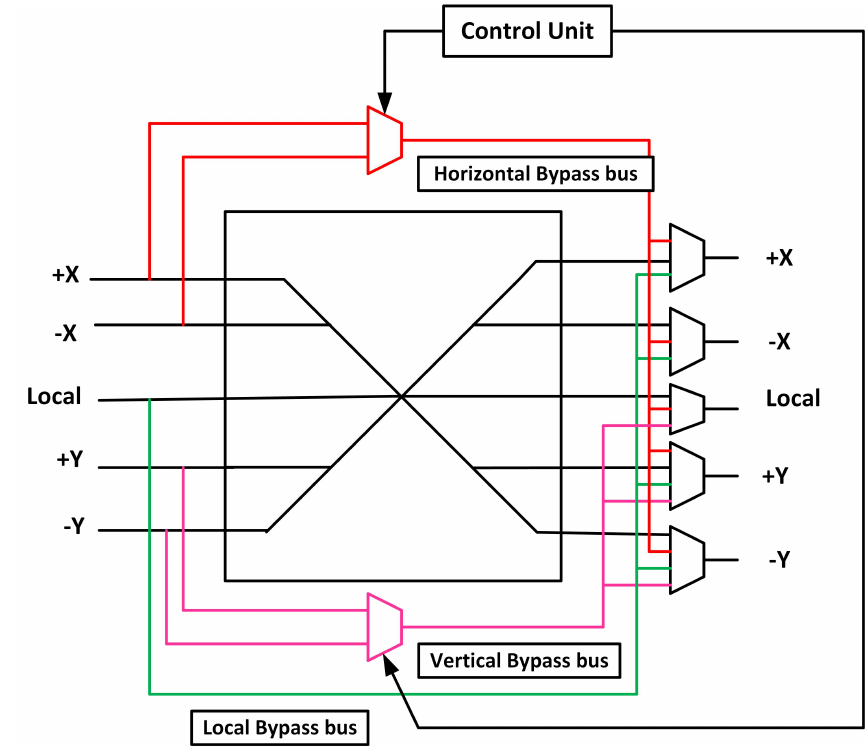
Figure 10. Crossbar (XBAR) fault-tolerant